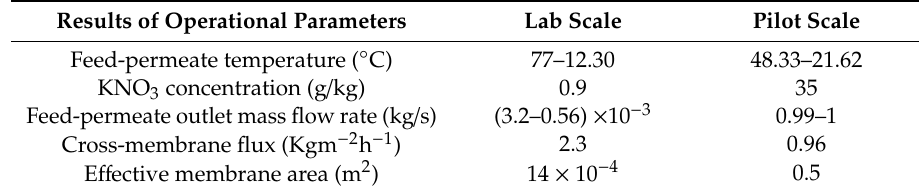
Table 1. Comparing the results of the operational parameters at the pilot and laboratory scales.